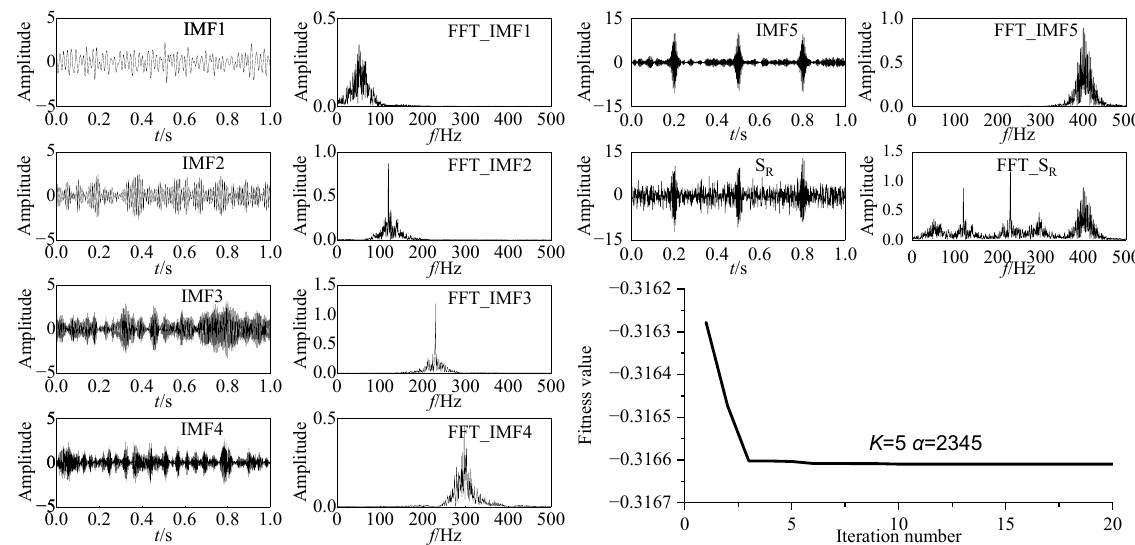
Figure 5. Decomposition results using optimized VMD with energy difference.